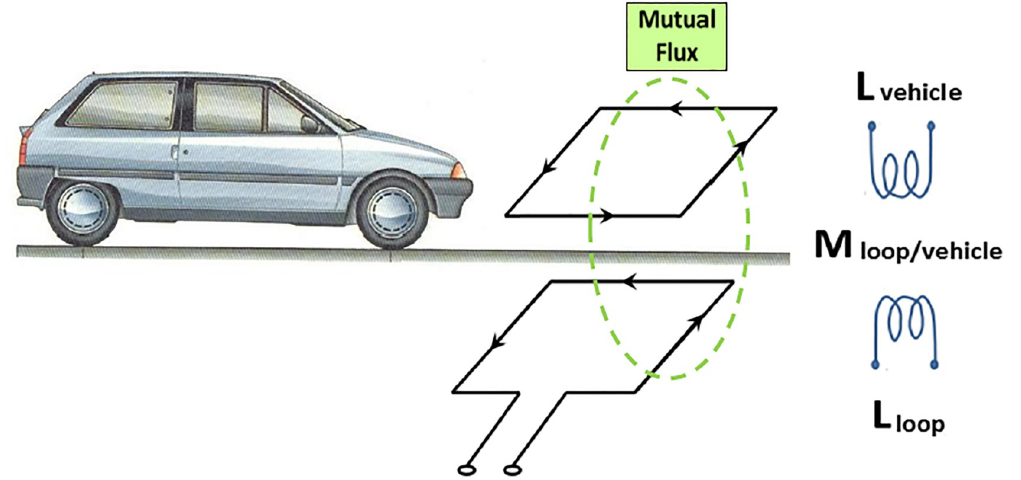
Fig 2. Model of a vehicle passing over the loop. The top represents the electronic model of the vehicle passing over the magnetic loop, which is represented at the bottom.